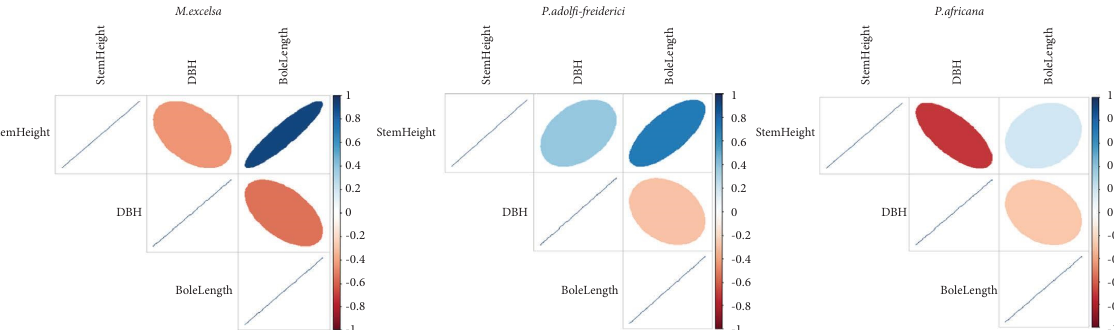
Figure 6: Plot of bivariate correlation ( r � − 1 to 1) between morphometric parameters clustering the populations of M.excelsa , P.adolf- freidericii, and P.africana . Te correlations are presented by colored circles (positive correlation in blue and negative correlation in red).